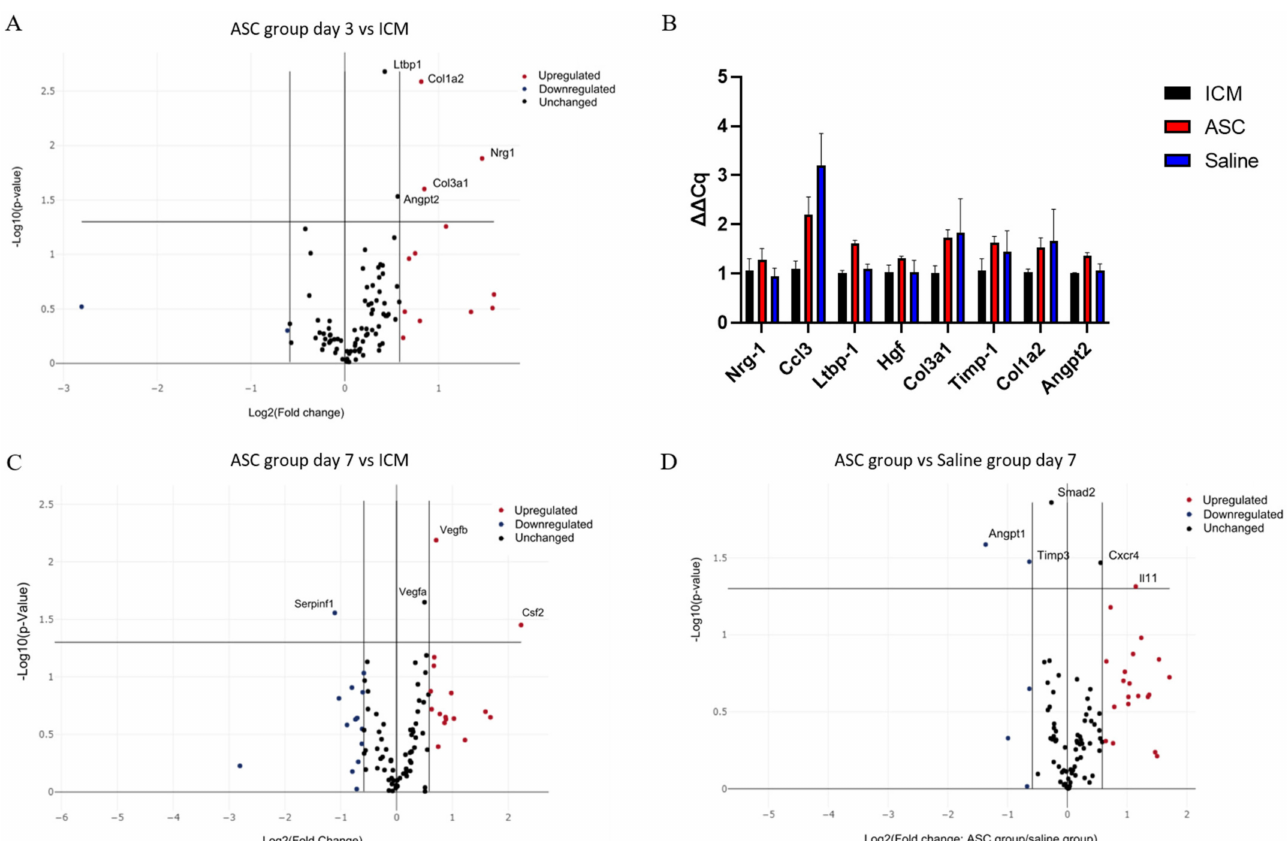
Figure 6. Effect of ASC treatment and saline administration on peri-infarct transcription. ( A ) Volcano plot of ASC vs. ICM hearts at day 3 after treatment. n = 5, 5. ( B ) Verifying qPCR of targets between ASC and saline groups at day 3 after treatment. Data are presented as ∆ Cq values calibrated to average of the ICM group. n = 3, 3, 4. ( C ) Volcano plots for comparison 7 days after treatment between ICM hearts and ASC treatment ( n = 5 and 4, respectively), or ( D ) ASC treatment vs. saline administration at day 7 ( n = 4 and 3, respectively). ICM; ischemic